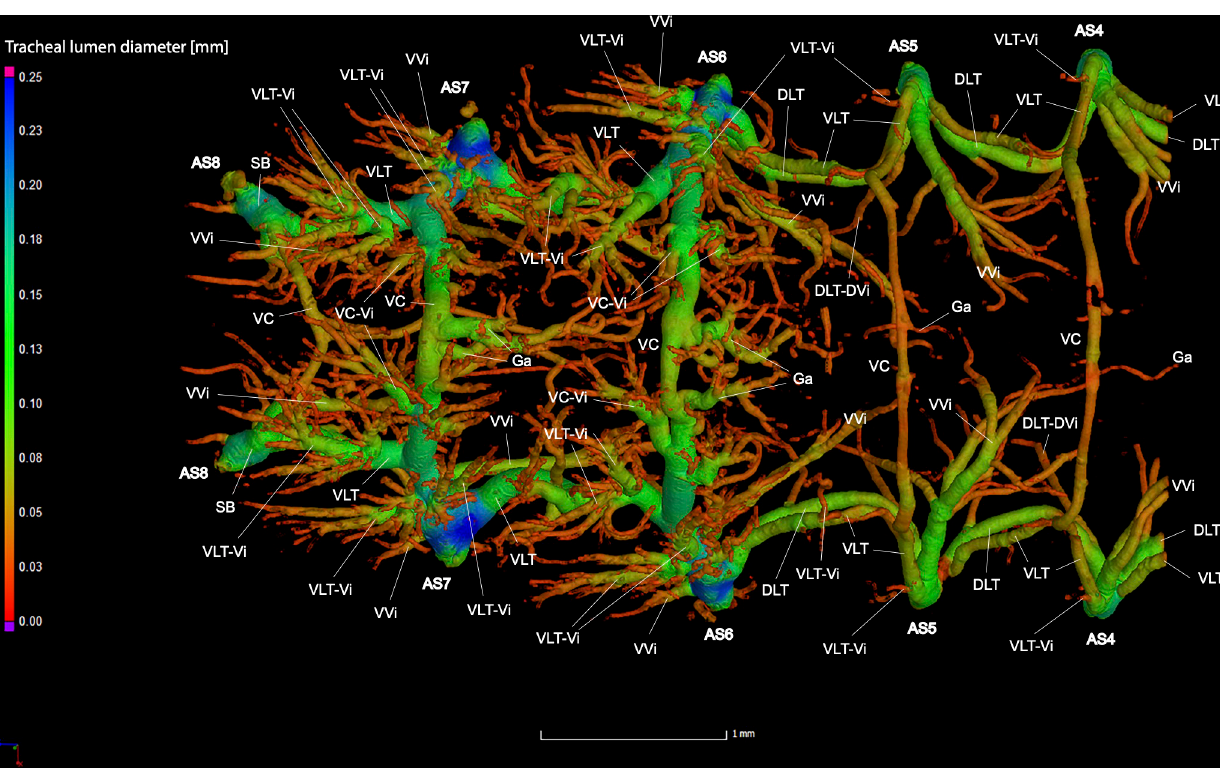
Fig 14. Ventral view of the abdominal tracheal system in adult male Photinus pyralis with smaller tracheae digitally removed. https://doi.org/10.1371/journal.pone.0268112.g014 PLOS ONE | https://doi.org/10.1371/journal.pone.0268112 June 1,